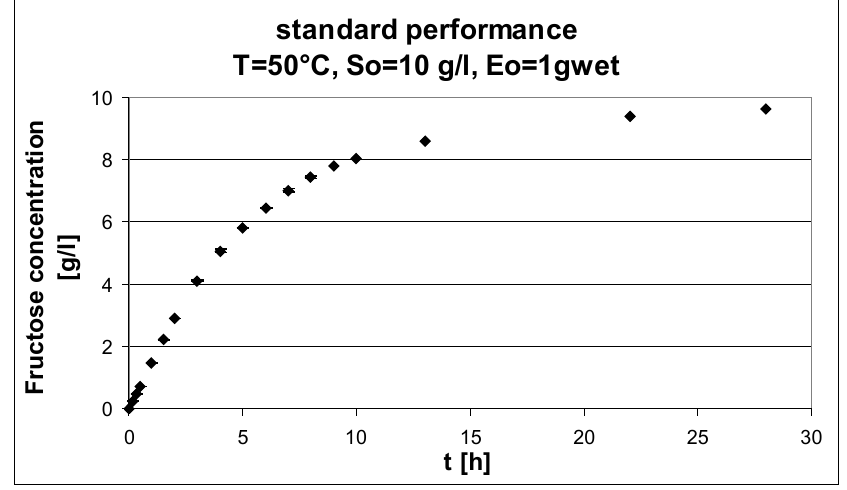
Figure 2. Standard performance of immobilized enzyme on long time scale (t = 28 h). standard